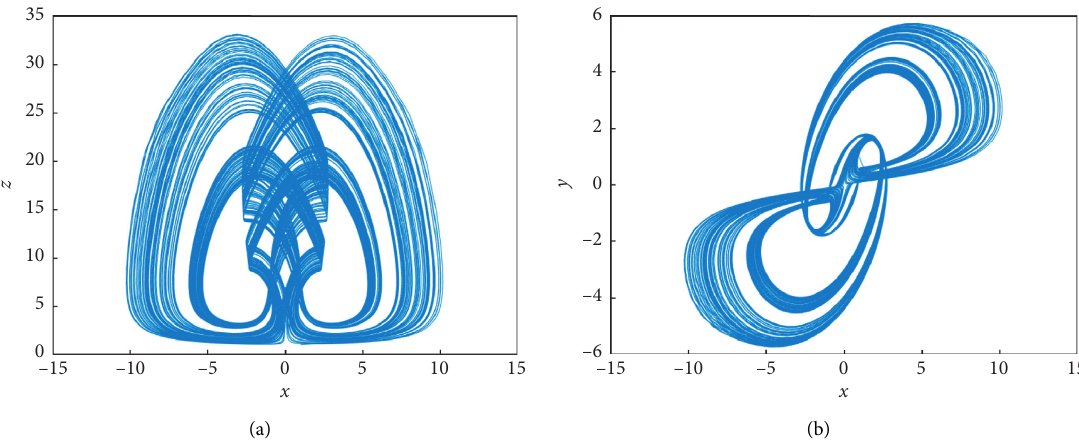
Figure 8: Phase portraits of the fractional system with α � 0 . 93.